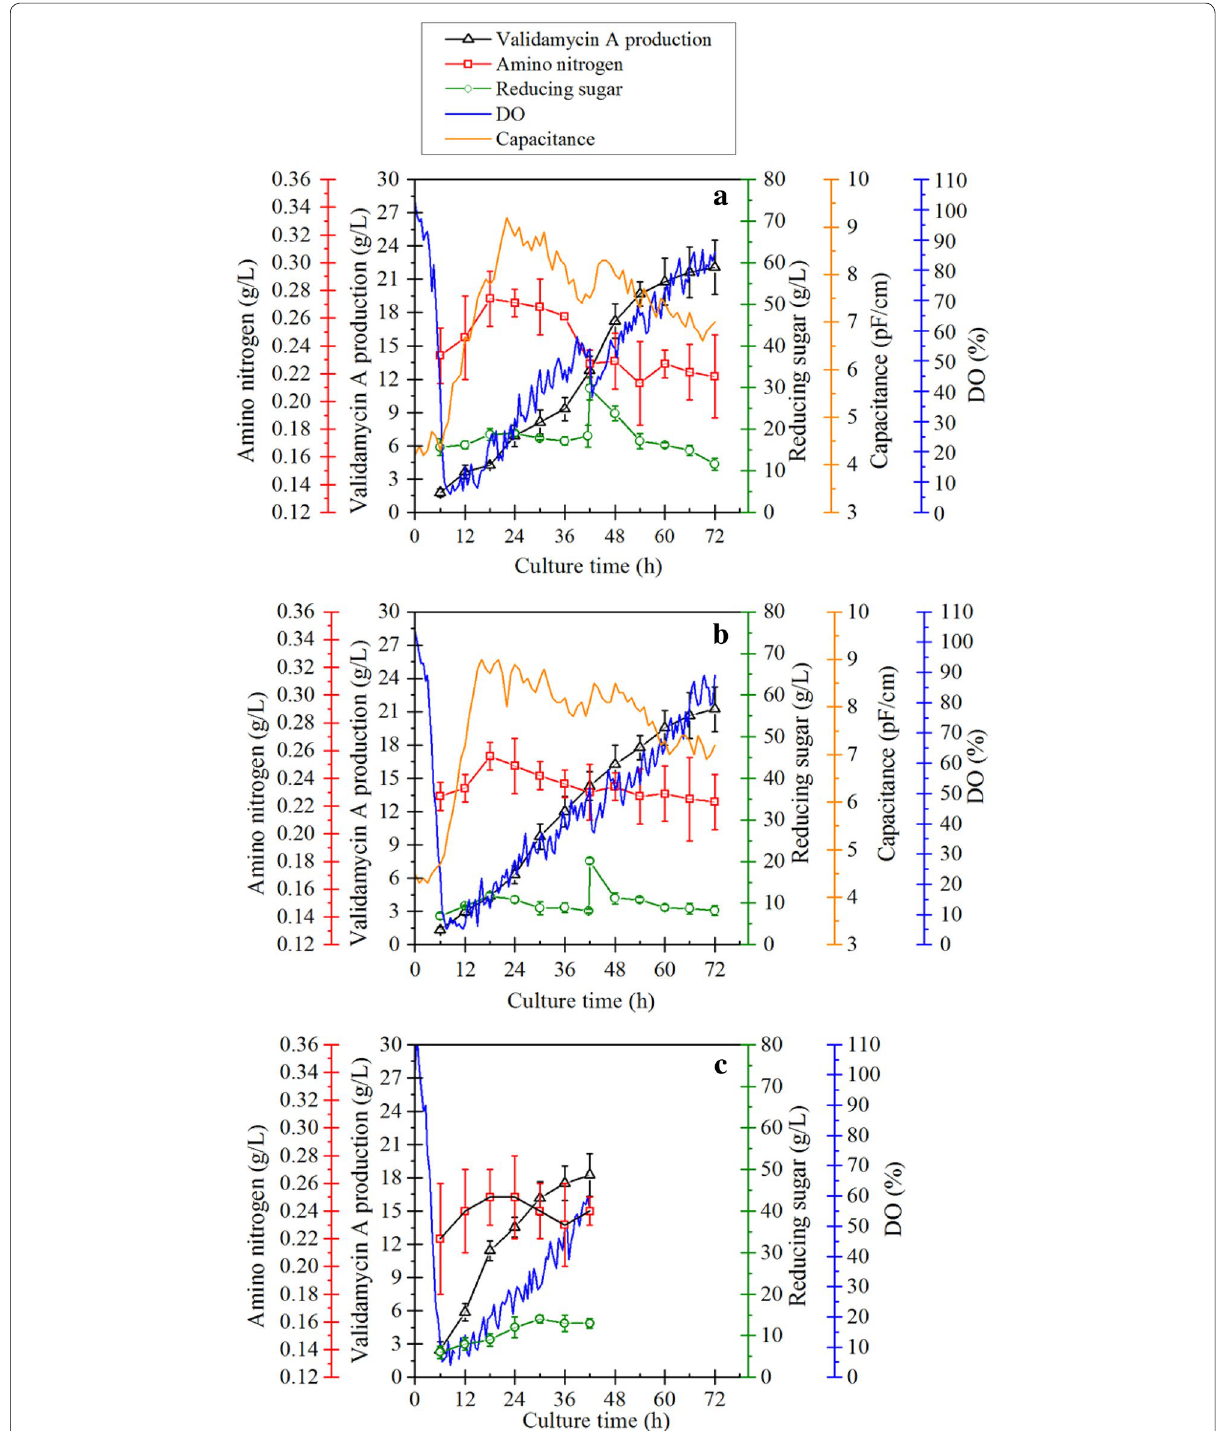
Fig. 3 Time courses of validamycin A fed-batch fermentation with ion-exchange wastewater in 50-L bioreactor ( a ) and 60 m 3 bioreactor ( b ); c the profile of batch fermentation with tap water in 60 m 3